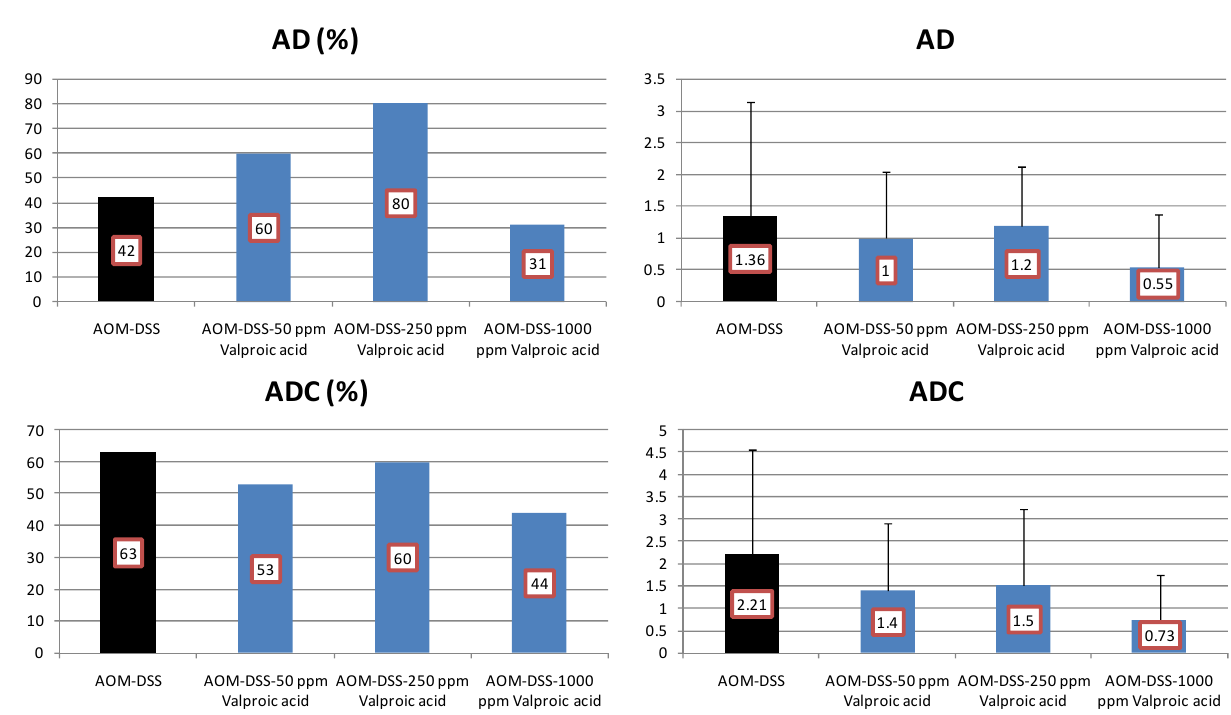
Figure 8. Incidences and multiplicities of adenoma (AD) and adenocarcinoma (ADC) in the Valproic Acid (VPA)